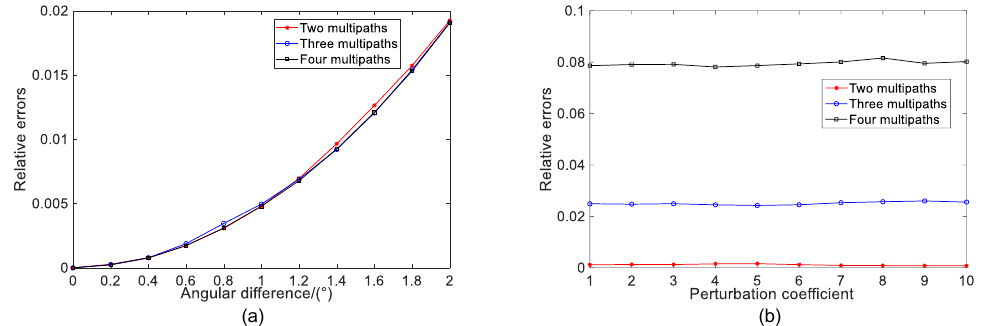
Figure 4. The equivalent multipath relative error results in complex terrain condition. ( a ) The relative error under different maximum angle differences. ( b ) The equivalent multipath relative errors at different β